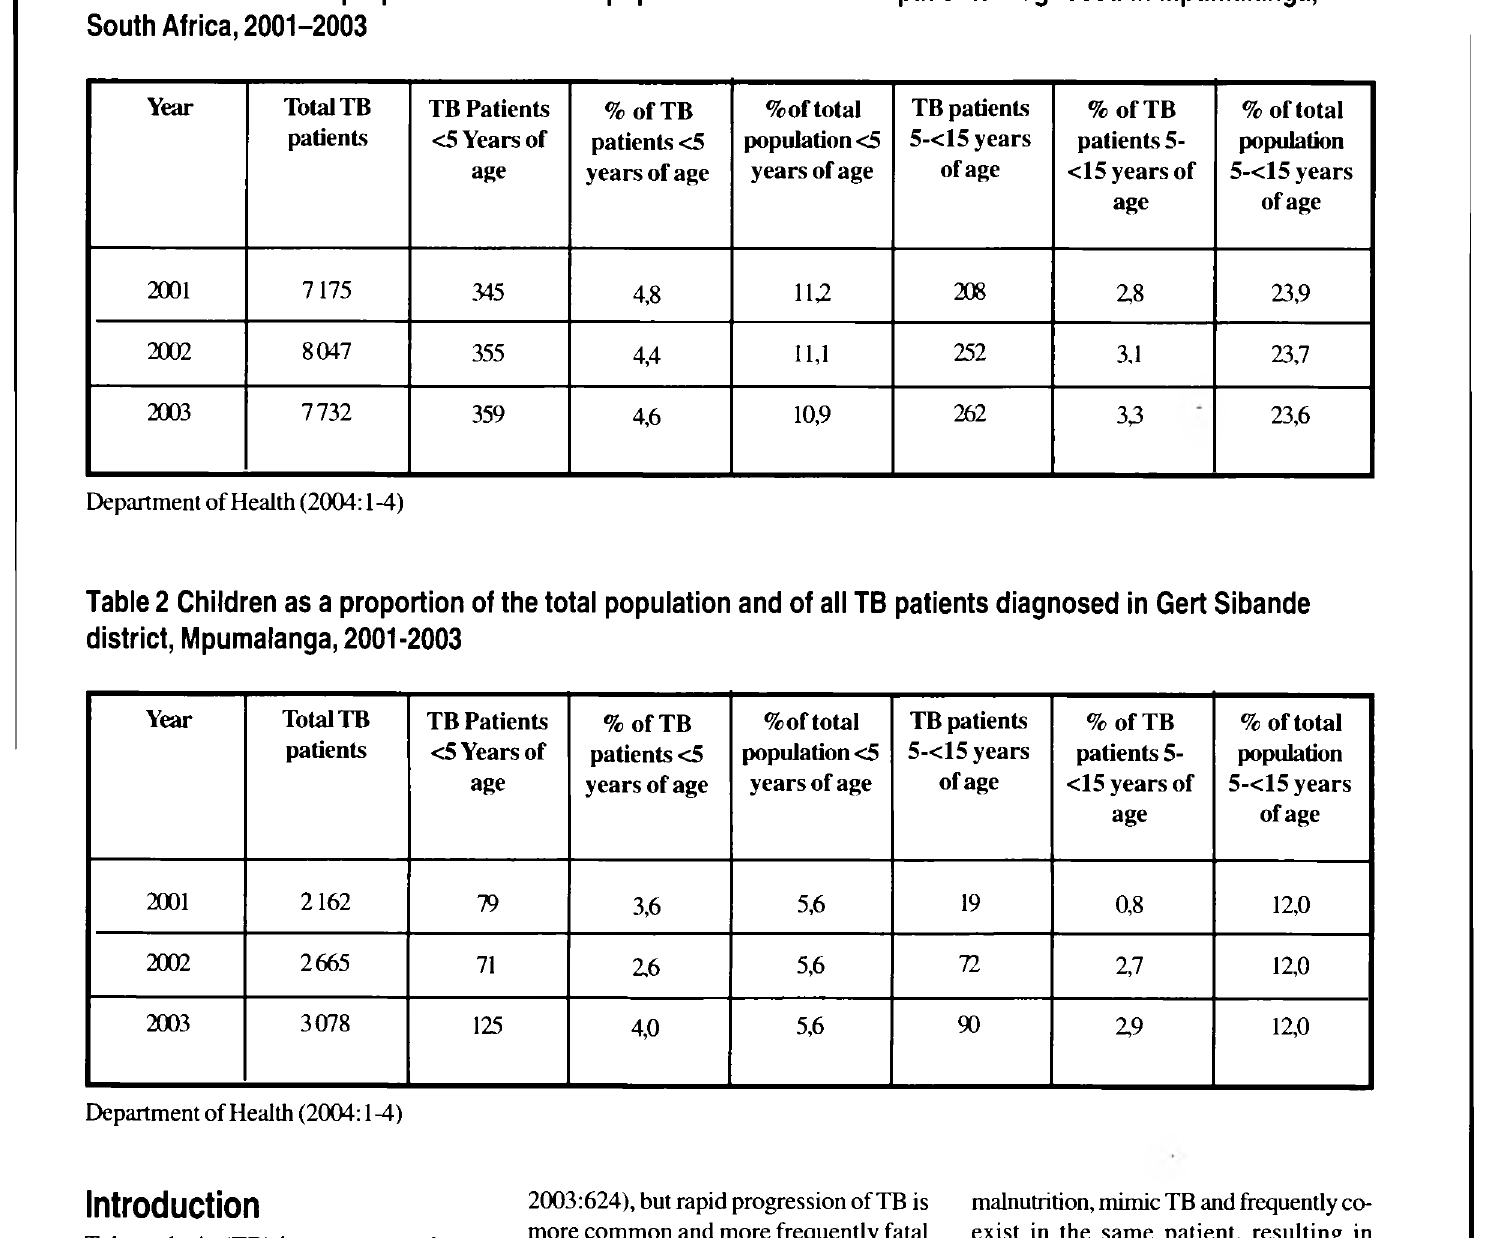
Table 1 Children as a proportion of the total population and of all TB patients diagnosed in